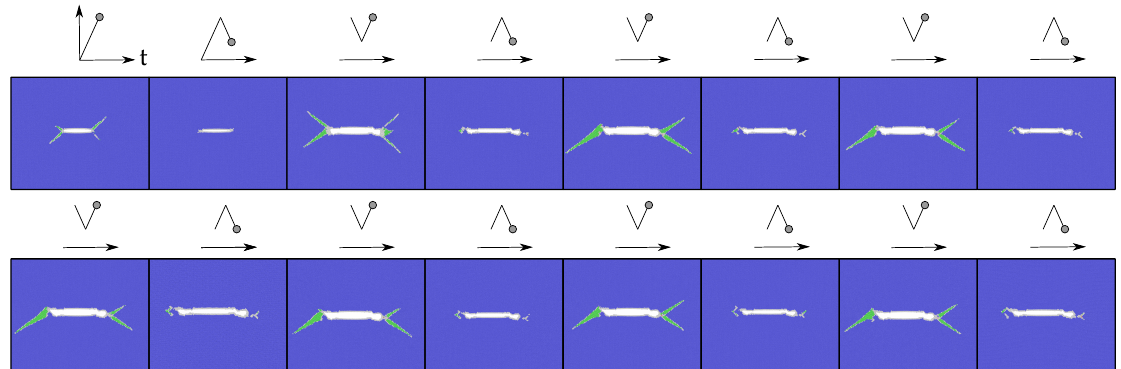
Figure 5. Evolution of the crack during cyclic loading. The images show the peak of the loading and unloading cycle for each of the eight cycles. The second row is a prolongation of the first. The colouring is presented according to common neighbour analysis. The blue colour indicates bcc, whereas the green notates fcc, and the red indicates the hcp iron structure. Particles belonging to an unidentified structure are visualised in